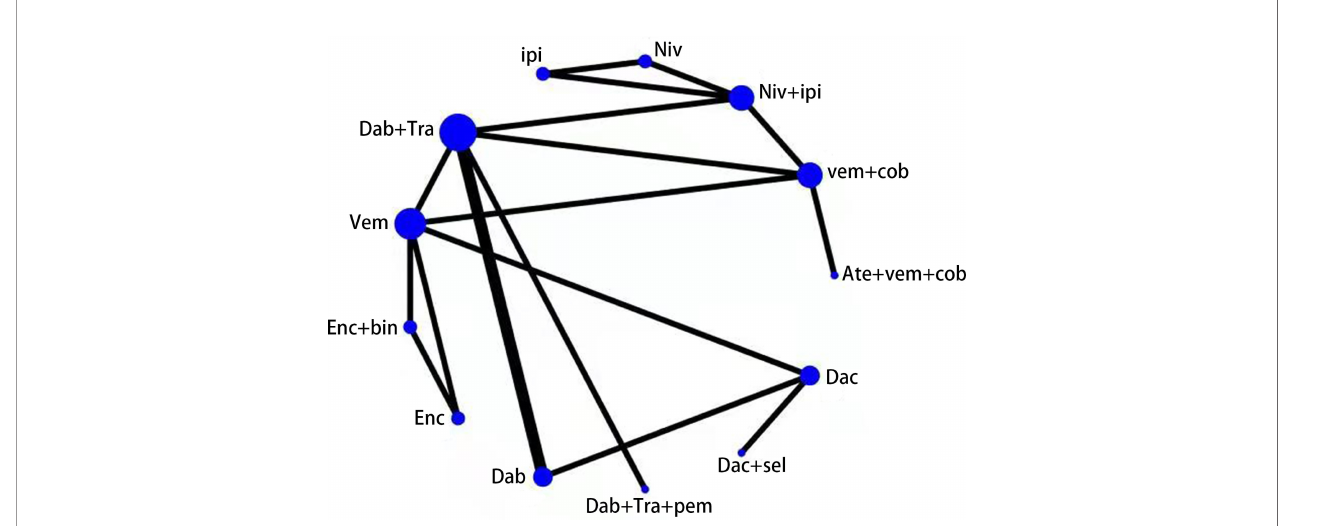
FIGURE 2 | Network diagram of 13 treatment regimens for BRAF V600-mutant melanoma in 12 trials. Ate+vem+cob, Atezolizumab plus Vemurafenib plus Cobimetinib; vem+cob, Vemurafenib plus Cobimetinib; Niv+ipi, Nivolumab plus Ipilimumab;Niv, Nivolumab; ipi, Ipilimumab; Dab+Tra, Dabrafenib plus Trametinib; Vem, Vemurafenib; Enc+bin, Encorafenib plus Binimetinib; Enc, Encorafenib; Dab, Dabrafenib; Dab+Tra+pem, Dabrafenib plus Trametinib plus Pembrolizumab; Dac +sel, Dacarbazine plus Selumetinib; Dac, Dacarbazine.Circular nodes indicate treatment regimens. The size of each circle corresponds with the number of participants, where the width of the lines indicate the number of